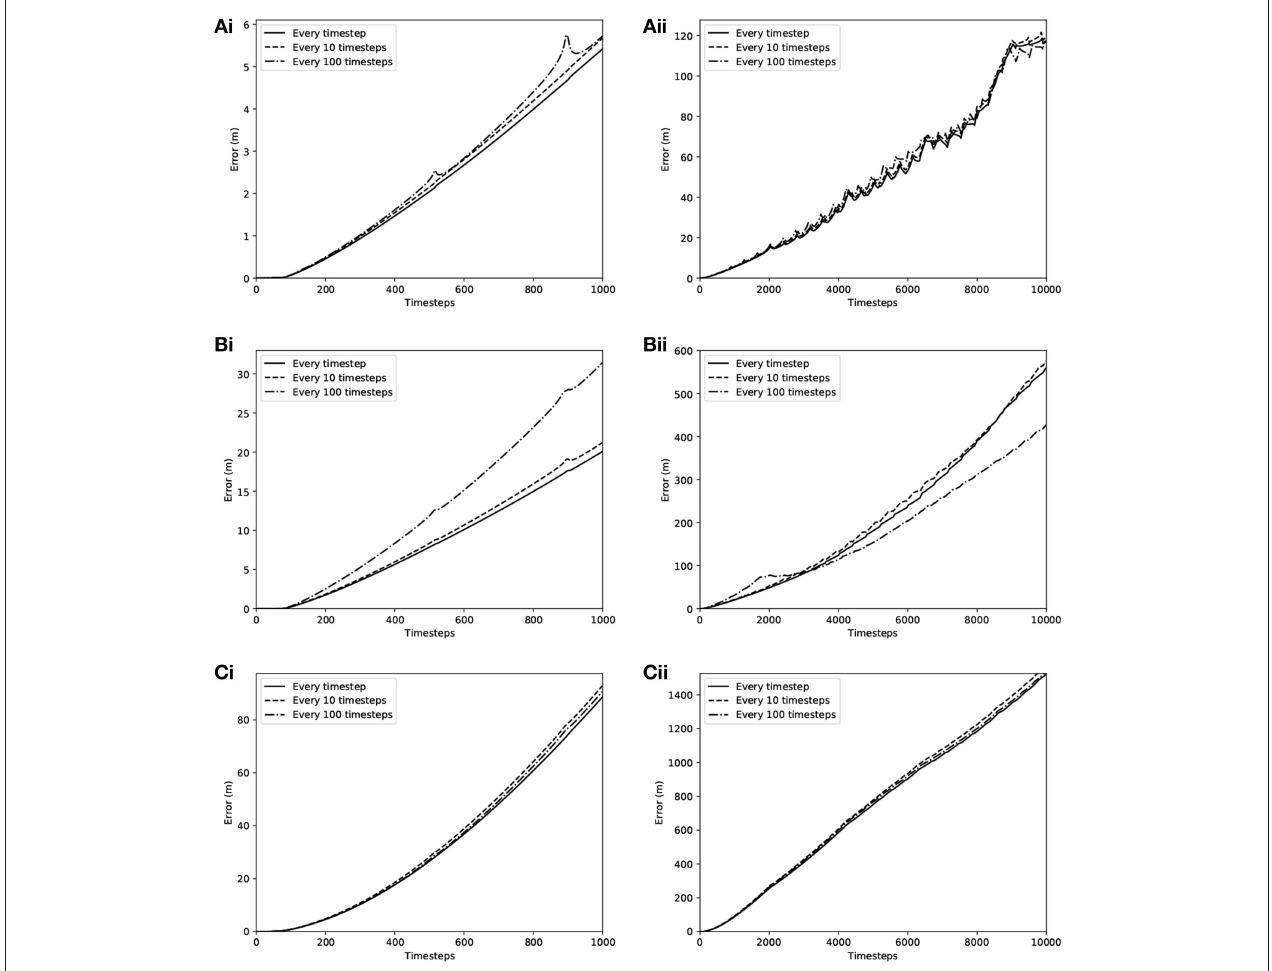
FIGURE 3 | Error when the NCC is performed: every timestep (solid lines), every 10 timesteps (dashed lines), and every 100 timesteps (dashed-dotted lines) vs. (i) 1000 timesteps, and (ii) 10,000 timesteps for: (A) K = 1 × 10 − 9 m/s 2 , (B) K = 1 × 10 − 8 m/s 2 , and (C) K = 1 × 10 − 7 m/s 2 .